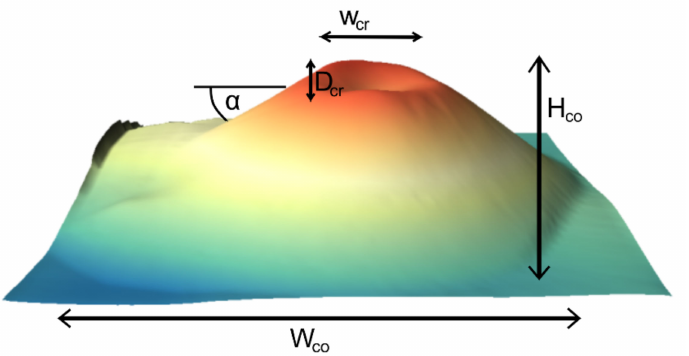
Figure 1. Classic morphometric parameters of a scoria cone: crater width (W cr ), crater depth ( D cr ), cone height ( H co ), base width ( W co ), and slope angle ( α